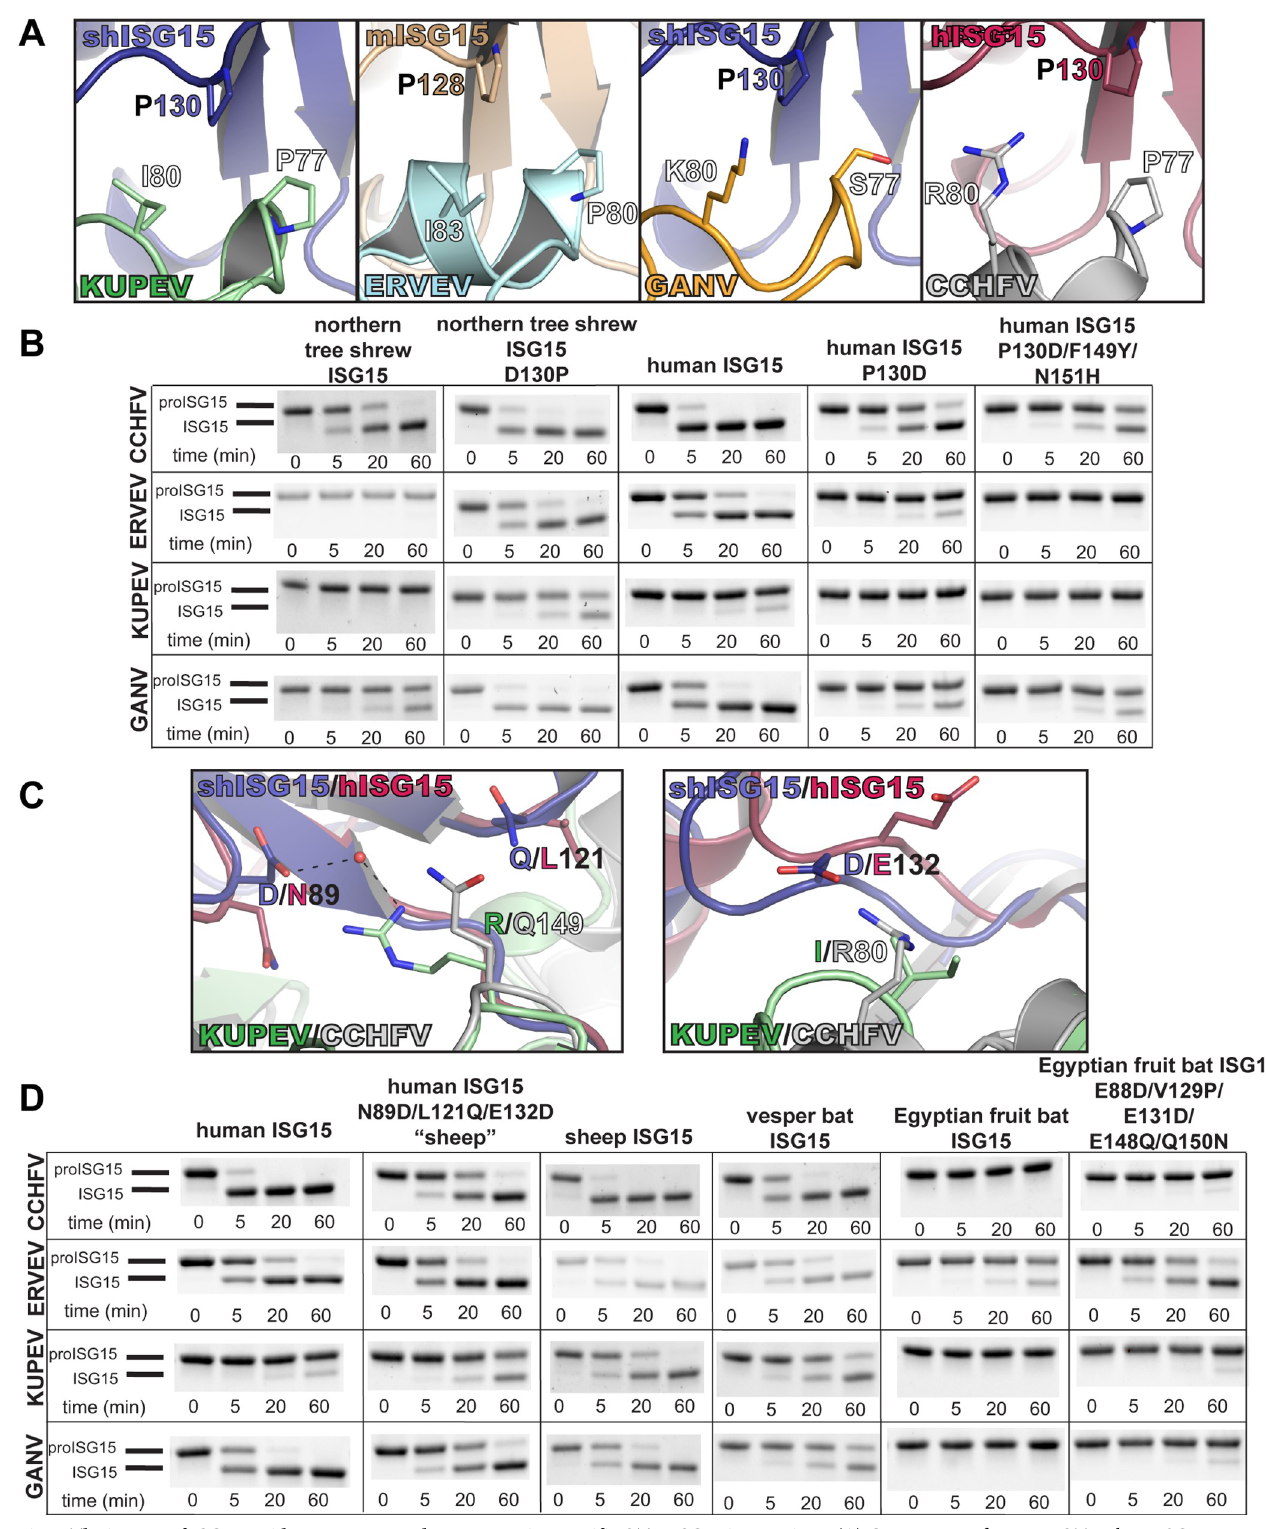
Fig 7. The impact of ISG15 residues 130, 121, and 132 on species-specific OTU-ISG15 interactions. (A) Comparison of KUPEV OTU-sheep ISG15, ERVEV OTU-C-mouse ISG15 (PDB ID 5JZE), GANV OTU-sheep ISG15, and CCHFV OTU-human ISG15 (PDB ID 3PHX) interactions between residue 130/128 of ISG15 and residues 77–80 of the OTU highlighting the variable sensitivity of this region. Cleavage assays show the relative impact of mutations